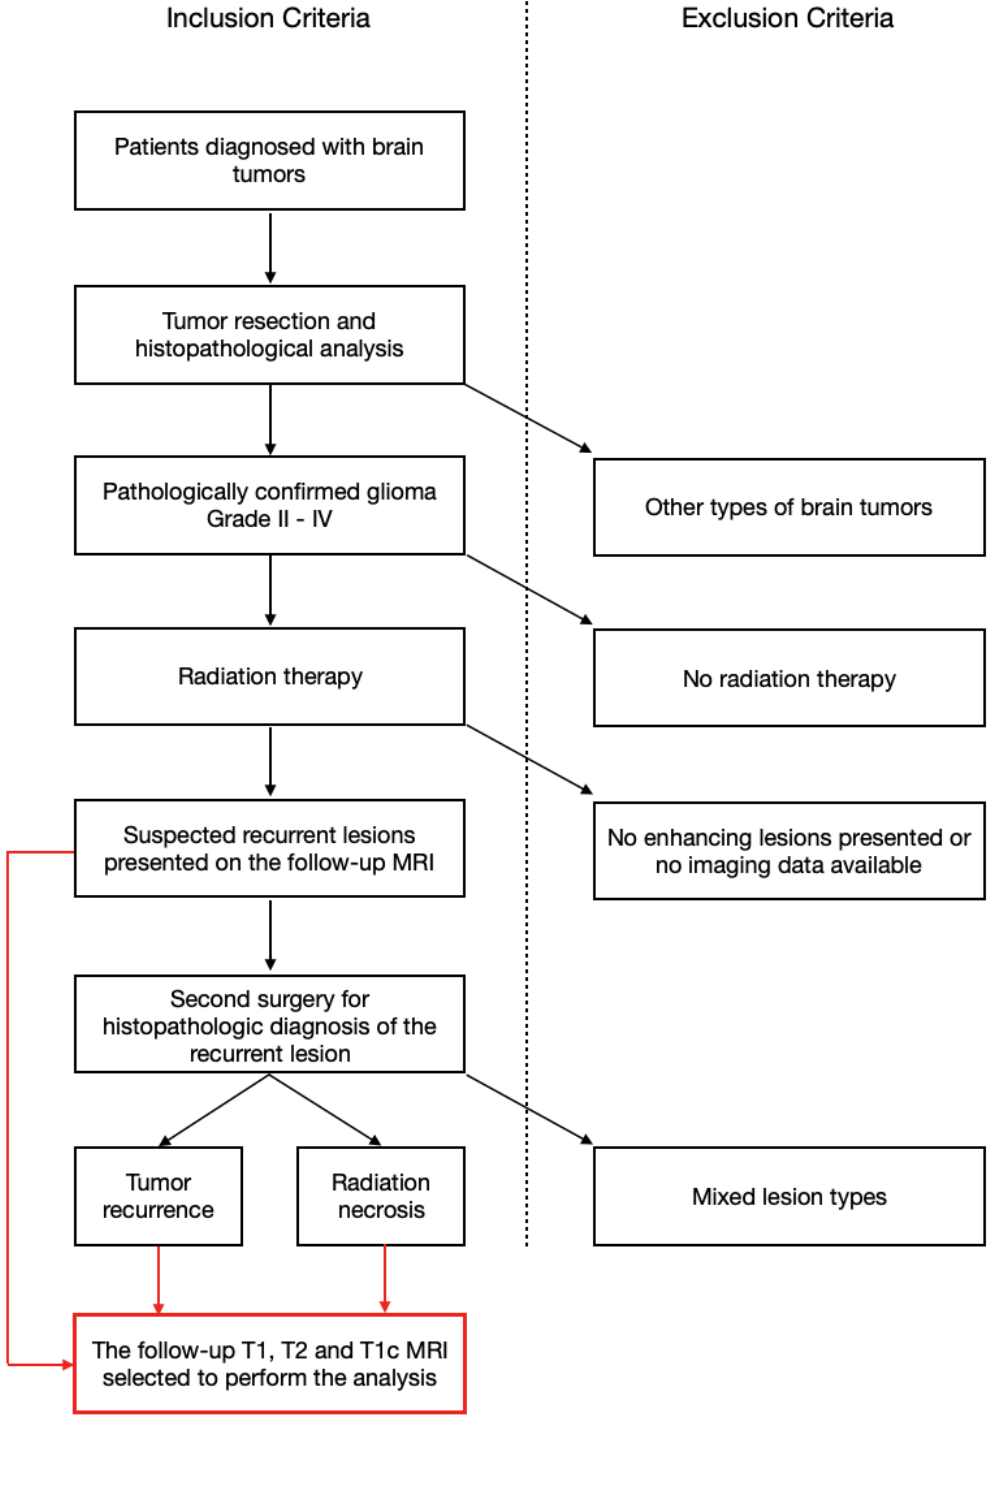
The selection process for the patient cohorts in this study. MRI: magnetic resonance imaging; T1: T1-weighted MRI; T1c: gadolinium-contrast-enhanced T1-weighted MRI; T2: T2-weighted